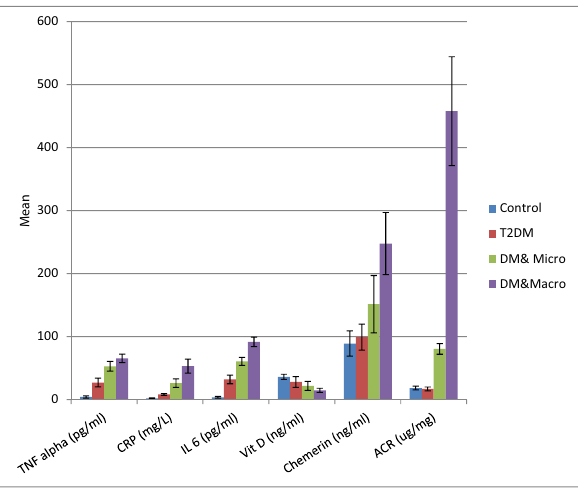
Figure 1: Vitamin D level and the in fl ammatory biomarkers in the four studied